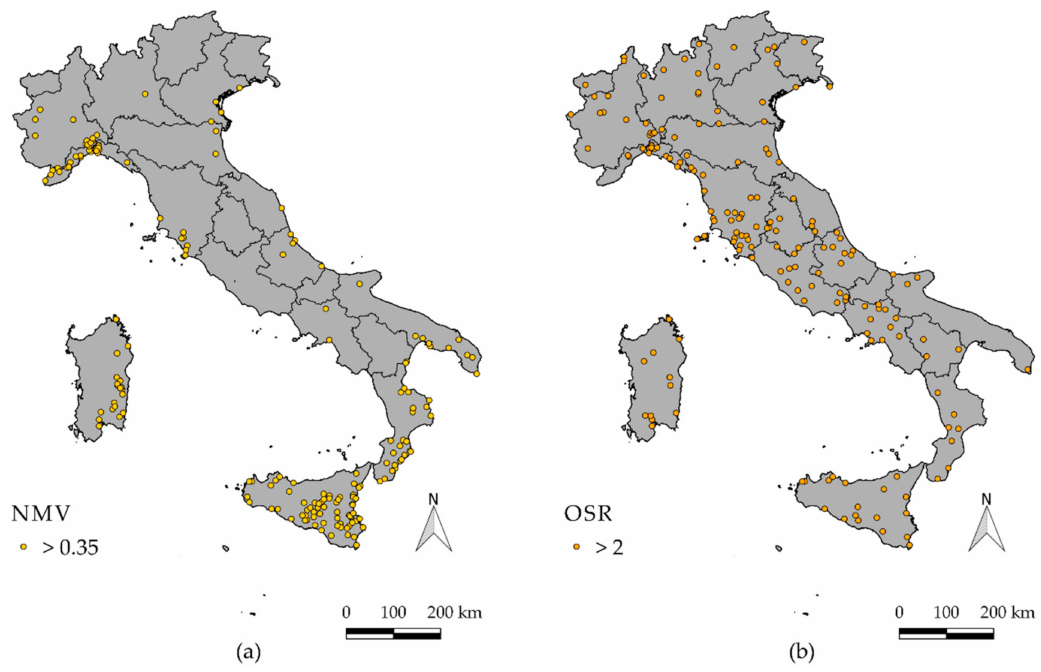
Figure 9. ( a ) NMV of the corrected 24-h dataset. Values lower than 0.35 were removed from the figure in order to highlight the localities where the most extreme rainfall events occurred. ( b ) Rain gauges characterized by greater OSR than 2 for the 24-h